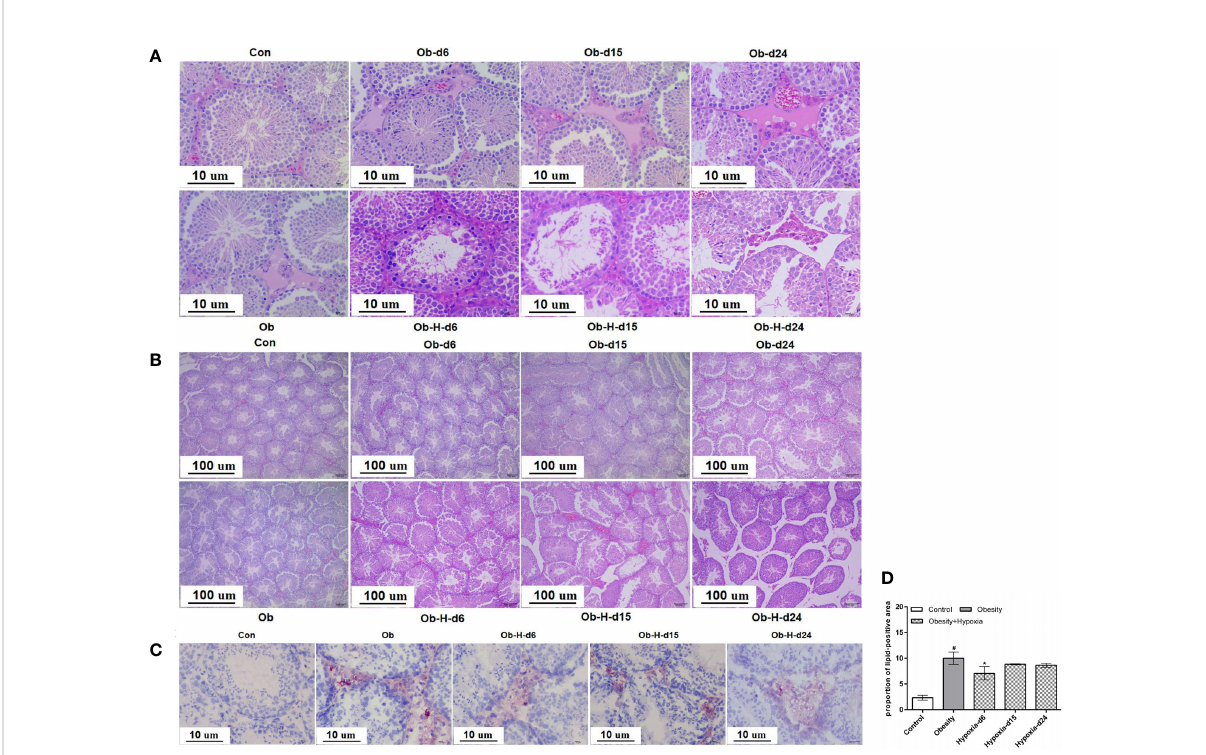
FIGURE 4 Impacts of chronic high-altitude hypoxia on the testicular histology of obese male mice. (A, B) The representative light microscopic histology images of testicular tissues. Magni fi cation: 100×, scale bar = 100 m m; 400×, scale bar = 10 m m. (C) Lipid accumulation in the interstitial tissues of testes by oil red O staining. Magni fi cation: 400×, scale bar = 10 m m. (D) Quantitative analysis of the lipid-positive areas in testicular interstitial tissues; (A, B) n = 5; (C, D) n = 4- 6. Data are represented as mean ± SEM. # P < 0.05 vs Con; * P < 0.05 vs Ob. Con, Control group; Ob, Obese group; Ob-H, Obese-Hypoxia